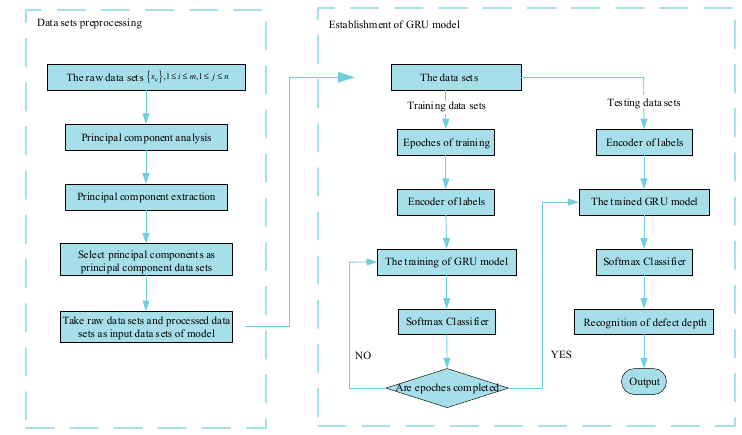
Figure 2. Framework of proposed defect depth recognition strategy.